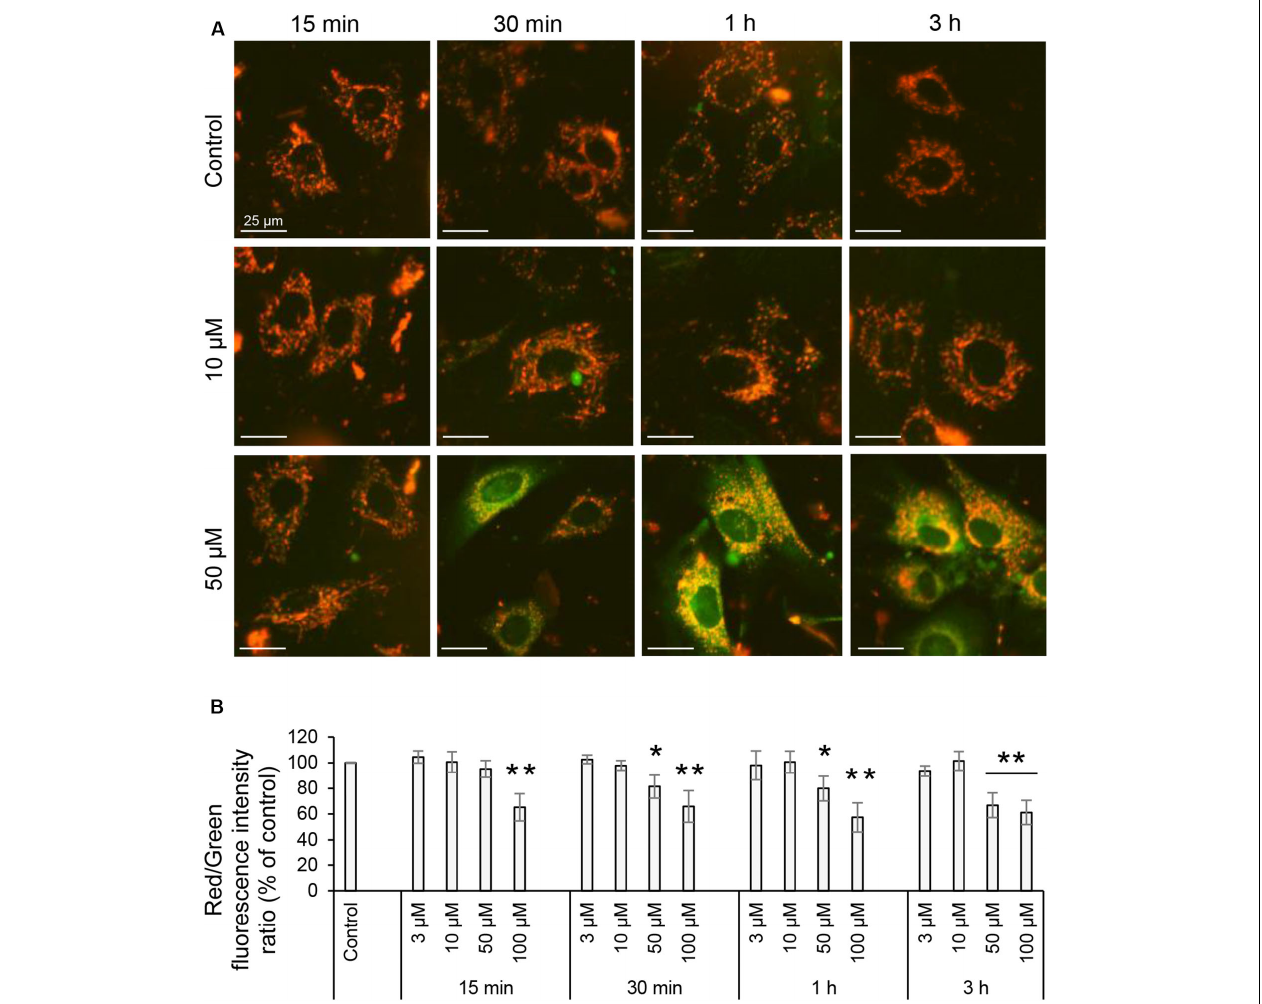
FIGURE 7 | Mitochondrial membrane potential of living fibroblasts induced with 3O-C 12 -HSL. (A) Cells were either treated with 0.02% DMSO as a diluent (Control), or exposed to 3, 10, 50, or 100 µ M 3O-C 12 -HSL and then stained with sensor JC-1 that exhibit MMP-dependent accumulation in mitochondria, indicated by a fluorescence shift between red and green. Living cells were visualized using IncuCyte Zoom live cell imaging and analysis system to measure fluorescence intensities. All images are merged between red (energized mitochondria) and green (depolarized mitochondria) fluorescence; orange indicate polarized mitochondria. Image size is 100 µ m × 100 µ m. Bar: 25 µ m. (B) Quantification of the mitochondrial polarization. The level of mitochondrial polarization was calculated as the ratio between red and green fluorescence intensities, and values were normalized to the diluent control (100%). Columns represent the mean ± SE for the ratio between red and green fluorescence intensities. Significant differences are indicated with * P < 0.05 and ** P < 0.01, as analyzed by two-tailed Student’s t -test. Data from at least six independent experiments performed on separate days on different cell passages, and at least 1500 cells per condition were